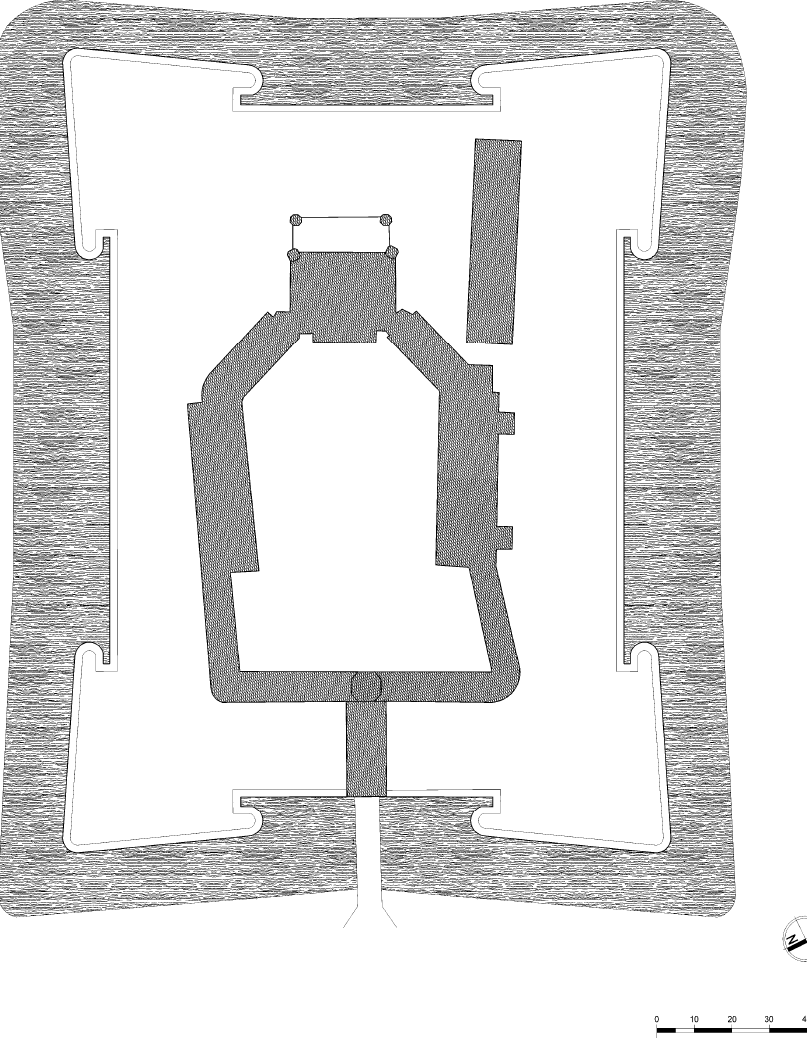
Figure 17. Nie´swie˙z: Radziwiłł’s residence—palace plan with fortifications; created by Figure 17. Nie ś wie ż : Radziwi łł ’s residence—palace plan with fortifications; created by authors.